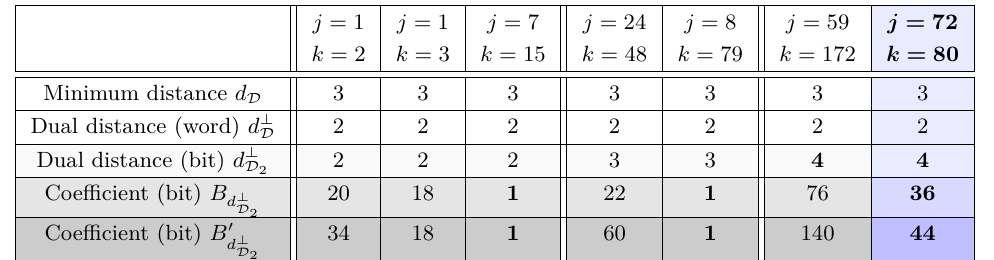
Table 2: Exhibiting different codes in (3 , 1)-SSS scheme generated by Eqn. 20. Note that we take α = α i = 1, α = α j and α = α k 1 2 3